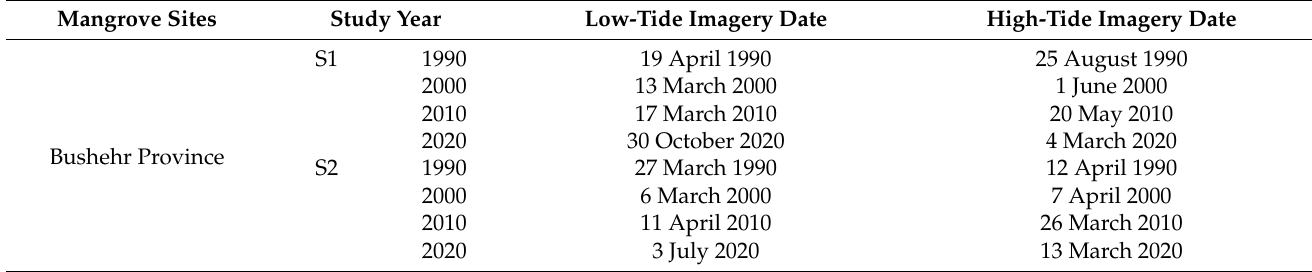
Table A1. Date of Landsat time series data used for each mangrove site in the present